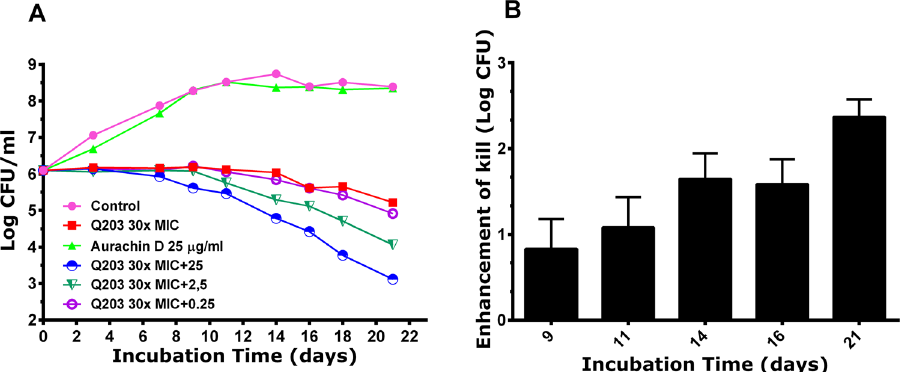
Figure 1. Kill-kinetics for combinations of cytochrome bcc and cytochrome bd inhibitors. 21-day time kill kinetics with M. tuberculosis H37Rv were performed in the presence of the cytochrome bcc inhibitor Q203 and the cytochrome bd inhibitor aurachin D. Panel (A) shows representative traces for the individual drugs and the combination of Q203 (30 × MIC) with the indicated concentrations aurachin D ( μ g/ml) as compared to DMSO control. Panel (B) shows the enhancement of killing by addition of aurachin D (25 μ g/ml) to the Q203 treated sample compared to killing by Q203 when applied alone. Average values were calculated from three independent experiments, error bars represent standard error of the mean.